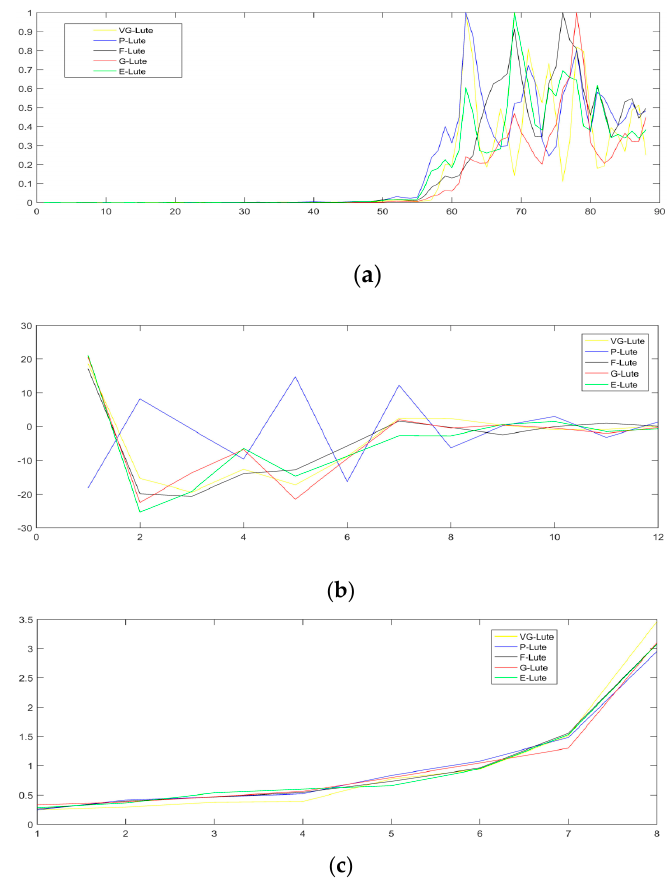
Figure 2. The acoustic features of 5 Chinese lutes. ( a ) Mean CQTs. ( b ) MFCCs. ( c )